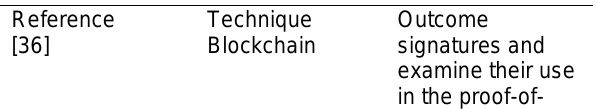
Table 1. comparative analysis of previous researches in a tabular